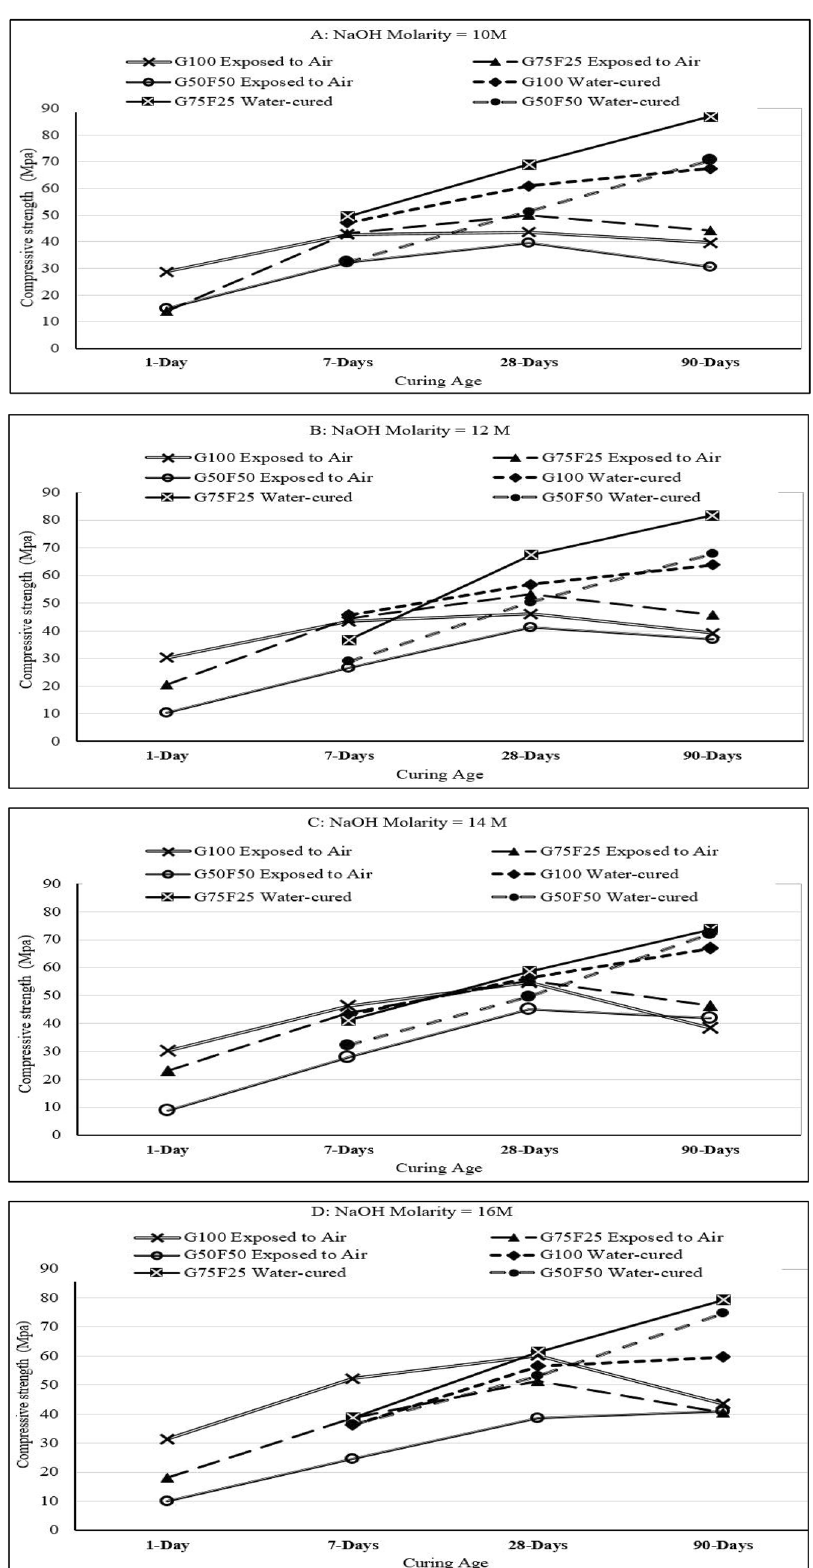
Figure 5. Strength development of G100, G75F25, and G50F50 air-cured and water cured alkali-activated mortars with NaOH molarity of : ( A ) 10M, ( B ) 12M, ( C ) 14M, and ( D )